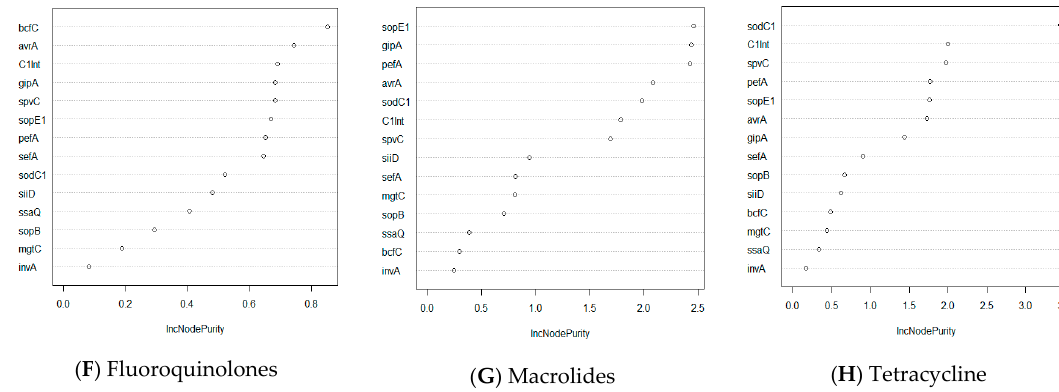
Figure 3. Random Forest analysis of association of virulence genes with resistance status by antibiotic class in Salmonella isolates ( n = 211). The y-axis indicates the importance score of each virulence gene. Virulence genes that are at top of the graph are the most important genes in determining resistance status (multidrug resistance, resistance to specific class of antibiotics, etc.). ( A ) Prediction of important virulence genes for all isolates that show any drug resistance. ( B ) Prediction of important virulence genes for isolates that are resistant to more than one drug. ( C – H ) Prediction of important virulence genes for all isolates that have resistance to a specific class of